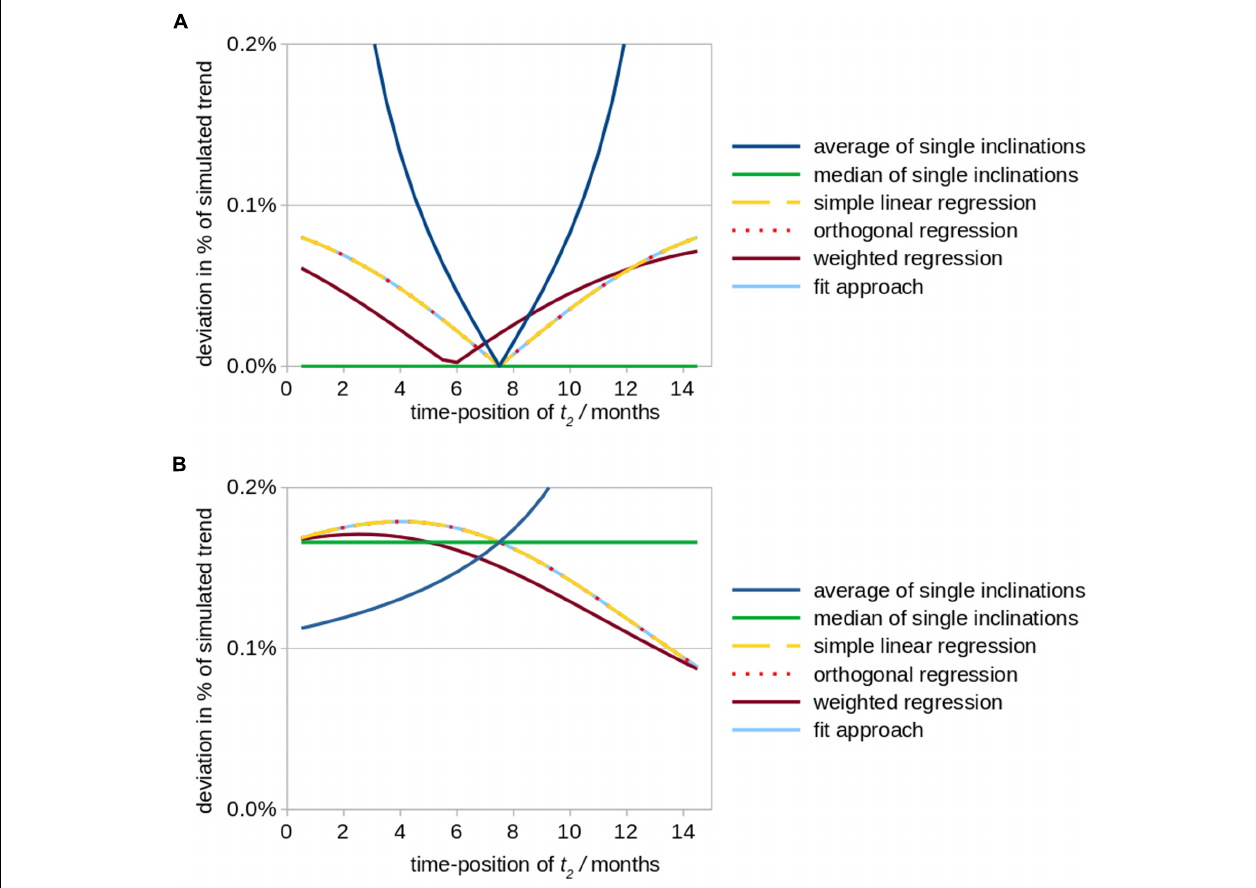
FIGURE 2 | Simulated effects of a modified positioning of time point t 2 (follow up 1) on calculations of striatal atrophy in Huntington patients. According to the underlying real world study (Müller et al., 2019), the total observation period amounted to 15 months and a monthly volume decrease of the striatum of 0.2% (in relation to its size at baseline) was assumed as original value of the overall linear trend. The position of time point t 2 was varied between a position just behind baseline up to almost 15 months, while the total study duration of 15 months was kept constant. Aberrational data values at time point t 2 (results shown in subfigure (A) and time point t 3 (B) were simulated by an arbitrary artificial offset value of +0.3% (in relation to the striatum size at baseline, i.e., 8.3 cm 3 ). The subfigures demonstrate the ensuing deviations (in percent of the original linear trend results) for different fit approaches. (A) Simulated aberration at t 2 (follow-up